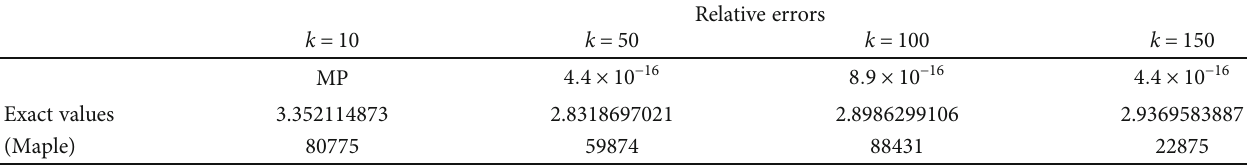
Table 3: Relative errors of the direct steepest descent method for .